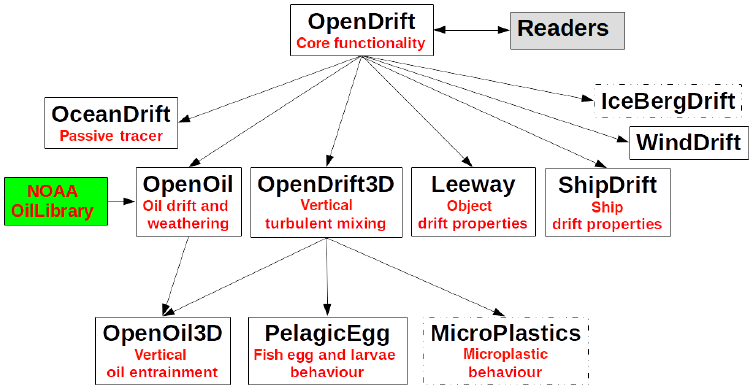
Figure 6. Illustration of how OpenDrift modules for specific applications (white boxes) inherit common functionality from the core module. This includes functionality to interact with Readers for obtaining forcing data. Subclassing (inheritance) allows, e.g. both the OpenOil and PelagicEgg models to share further 3-D-functionality through subclassing the OpenDrift3D class. The boxes with solid boundaries illustrate existing modules bundled with the OpenDrift repository, whereas dashed boundaries indicate planned modules. The green box illustrates that OpenOil (oil drift model) utilises functionality from a third-party library, the NOAA